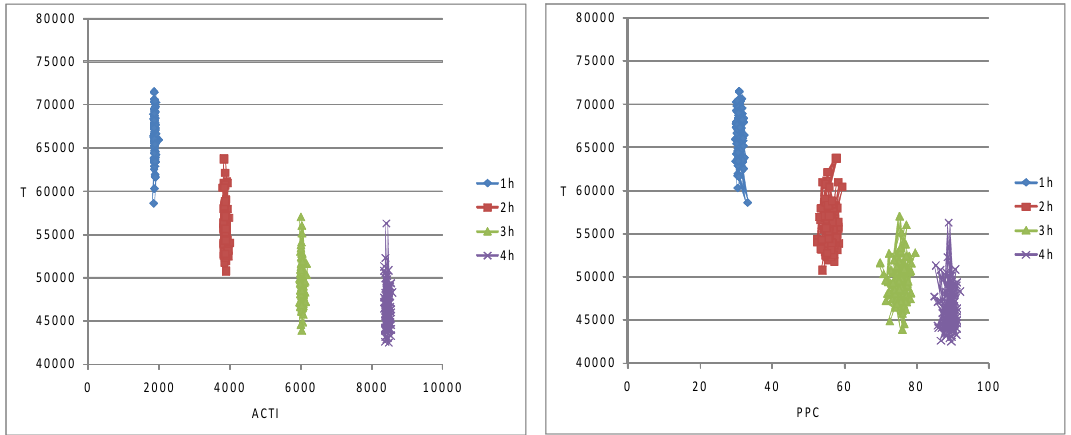
Figure 4. Travel cost (in seconds) related to ACTI and PPC